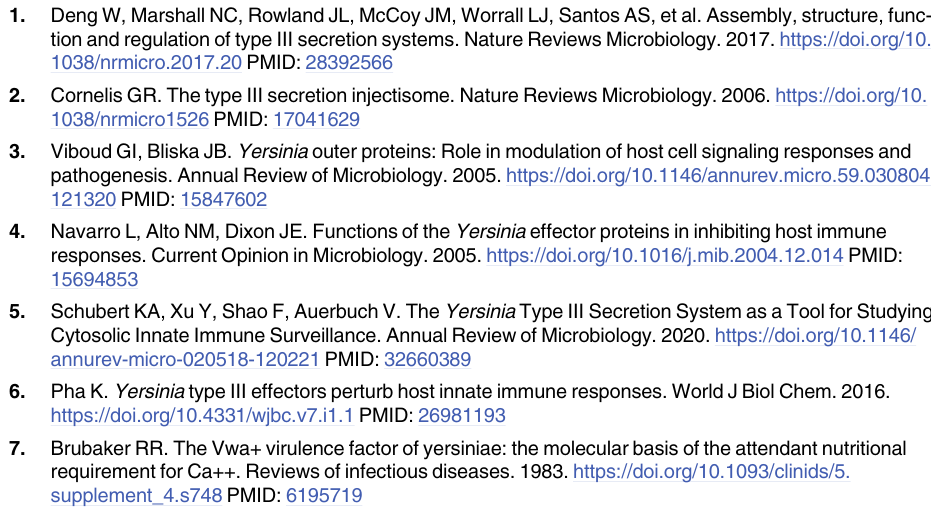
Table C in S1 Text. Plasmids used in this